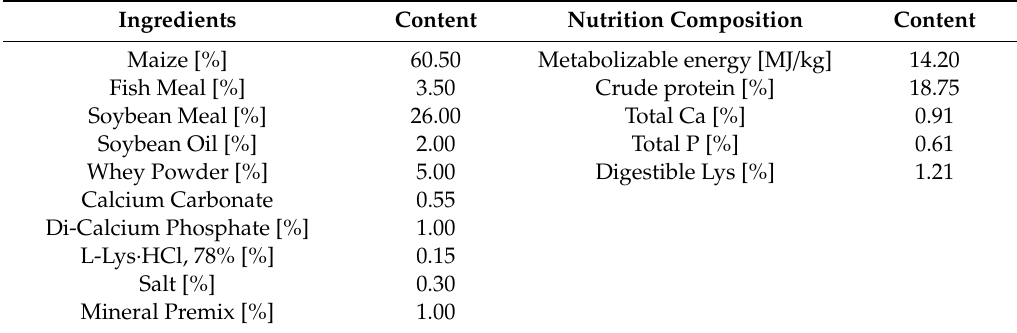
Table 1. Chemical composition and ingredients of the basal